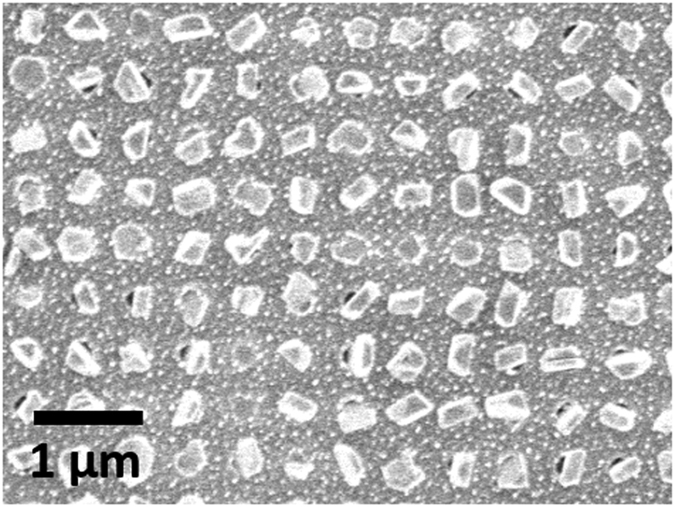
SEM image of Sb2Te3 single nano-crystal array grown by CVD onto patterned SiO2/TiN substrates with circular nanoscale holes under excess precursor flow.